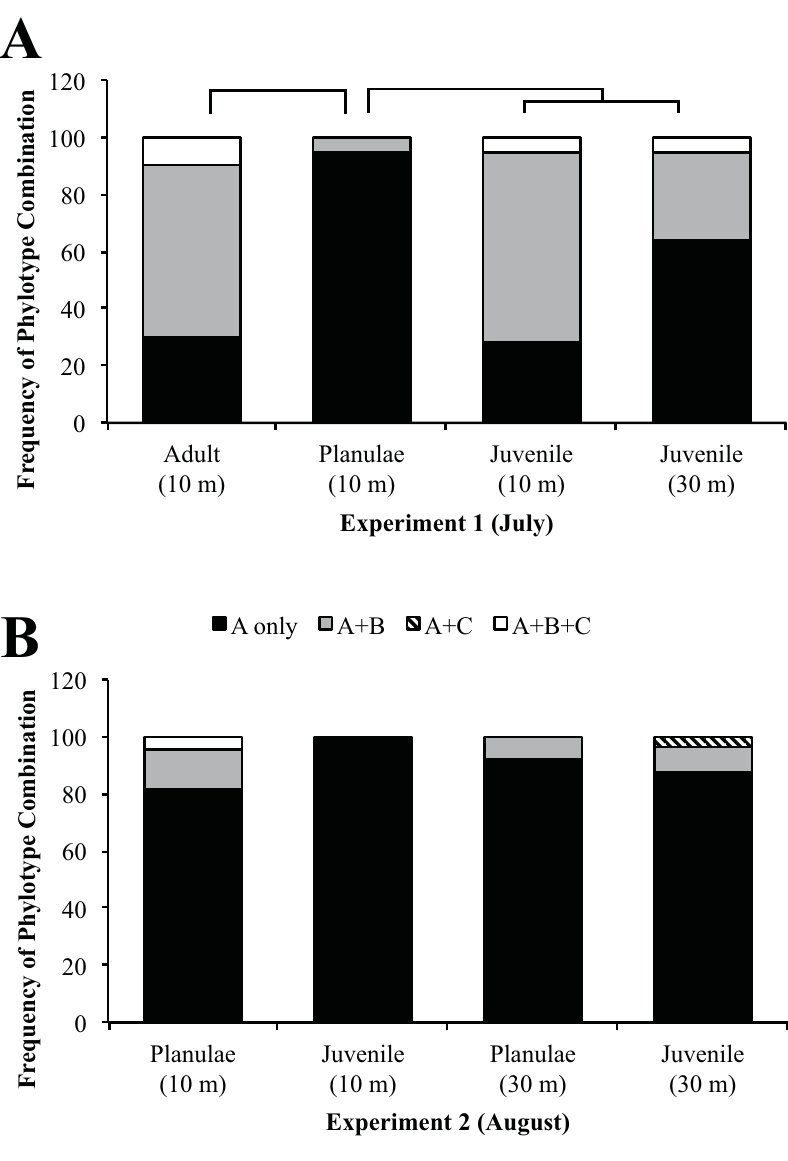
Fig 4. Symbiodinium phylotype composition in various Porites astreoides life stages reared in situ (A) and ex situ (B). (A) Symbiodinium phylotypecomposition of shallow P . astreoides adults, their brooded planulae,and newly settled juveniles reared in situ on shallow(10 m) and upper mesophotic(30 m) reefs. Symbiodinium phylotypefrequencies differed significantlybetween(1) adults and planulae,(2) planulaeand juveniles transplanted to the shallowreef, (3) planulaeand juvenilestransplantedto the upper mesophotic reef, and (4) betweenjuvenilestransplantedto the different depths. There was no difference in Symbiodinium phylotypefrequencies betweenadults and juvenilestransplanted to different depths. (B) Symbiodinium phylotypecomposition of planulaeand ex situ , reared juvenile P . astreoides . No difference was found in Symbiodinium phylotypefrequency of (1) planulaeor juvenilesfrom different parentaldepths or (2) between planulaeand juvenile. shallow (62.63%±6.33%; average ± standard error) and upper mesophotic (74.22%±5.40%) juveniles reared ex situ in outdoor aquaria (t-test, p = 0.17).